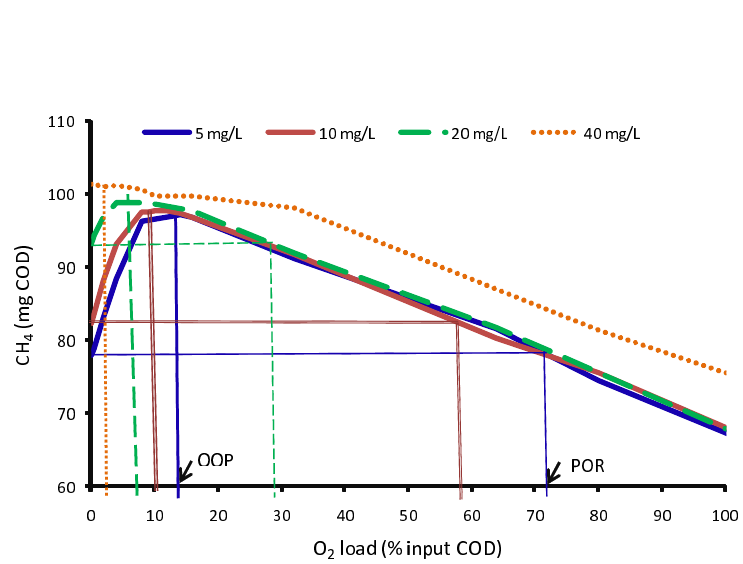
Figure 7: ADM 1-Ox batch mode simulations for different initial biomass concentrations ( X B ) indicating the shifting of OOP and POR ( K h = 10 m 3 /kg COD. d. ; k L a = 4000 d − 1 , starch feed of 1 . 09 kg COD/m 3 ).